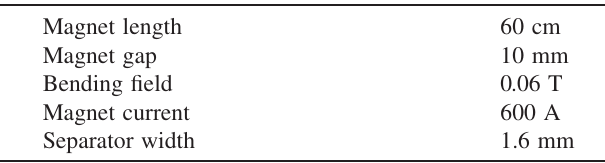
TABLE II. Parameters of the auxiliary septum.